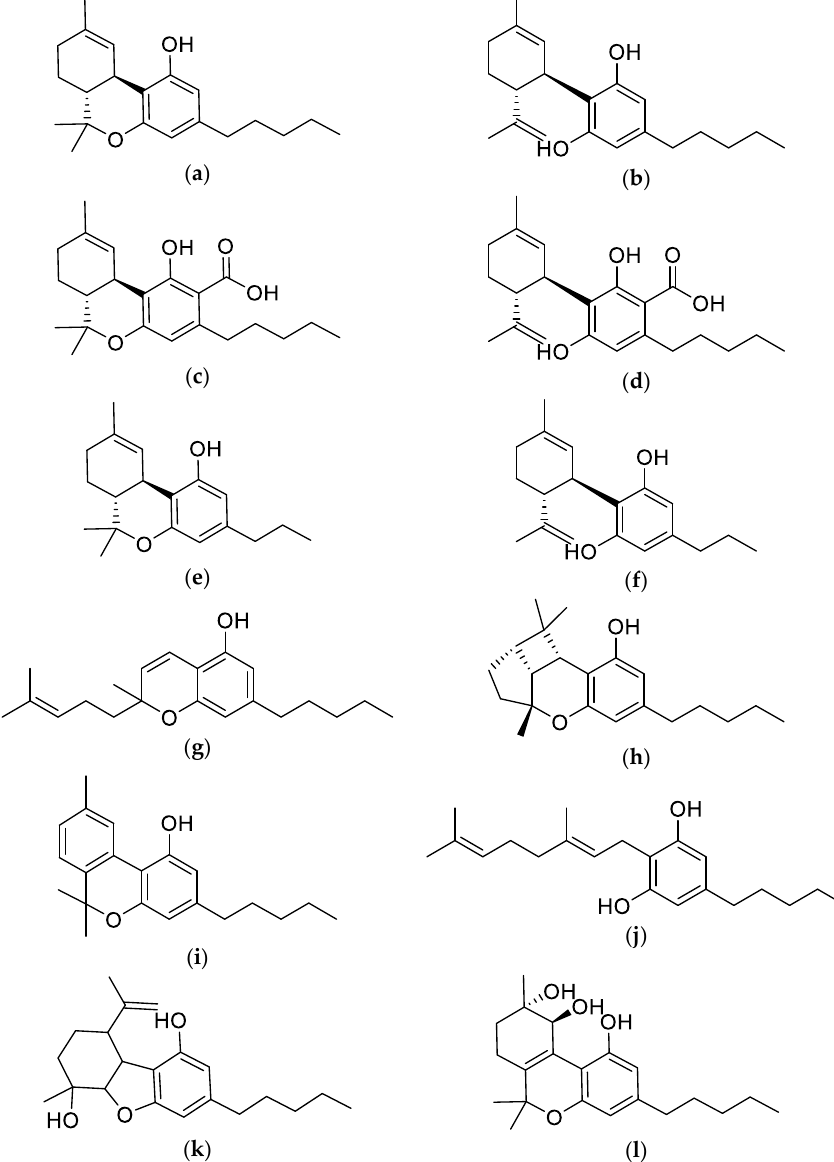
Figure 1. Chemical structures of major phytocannabinoids. ( a ) Δ 9 -Tetrahydrocannabinol (Δ 9 -THC); ( b ) Cannabidiol (CBD); ( c ) Δ 9 -Tetrahydrocannabinolic Acid (Δ 9 -THCA); ( d ) Cannabidiolic Acid (CBDA); ( e ) Δ 9 -Tetrahydrocannabivarin (THCV); ( f ) Cannabidivarin (CBDV); ( g ) Cannabichromene (CBC); ( h ) Cannabicyclol (CBL); ( i ) Cannabinol (CBN); ( j ) Cannabigerol (CBG); ( k ) Cannabielsoin (CBE); ( l ) Cannabitriol (CBT).